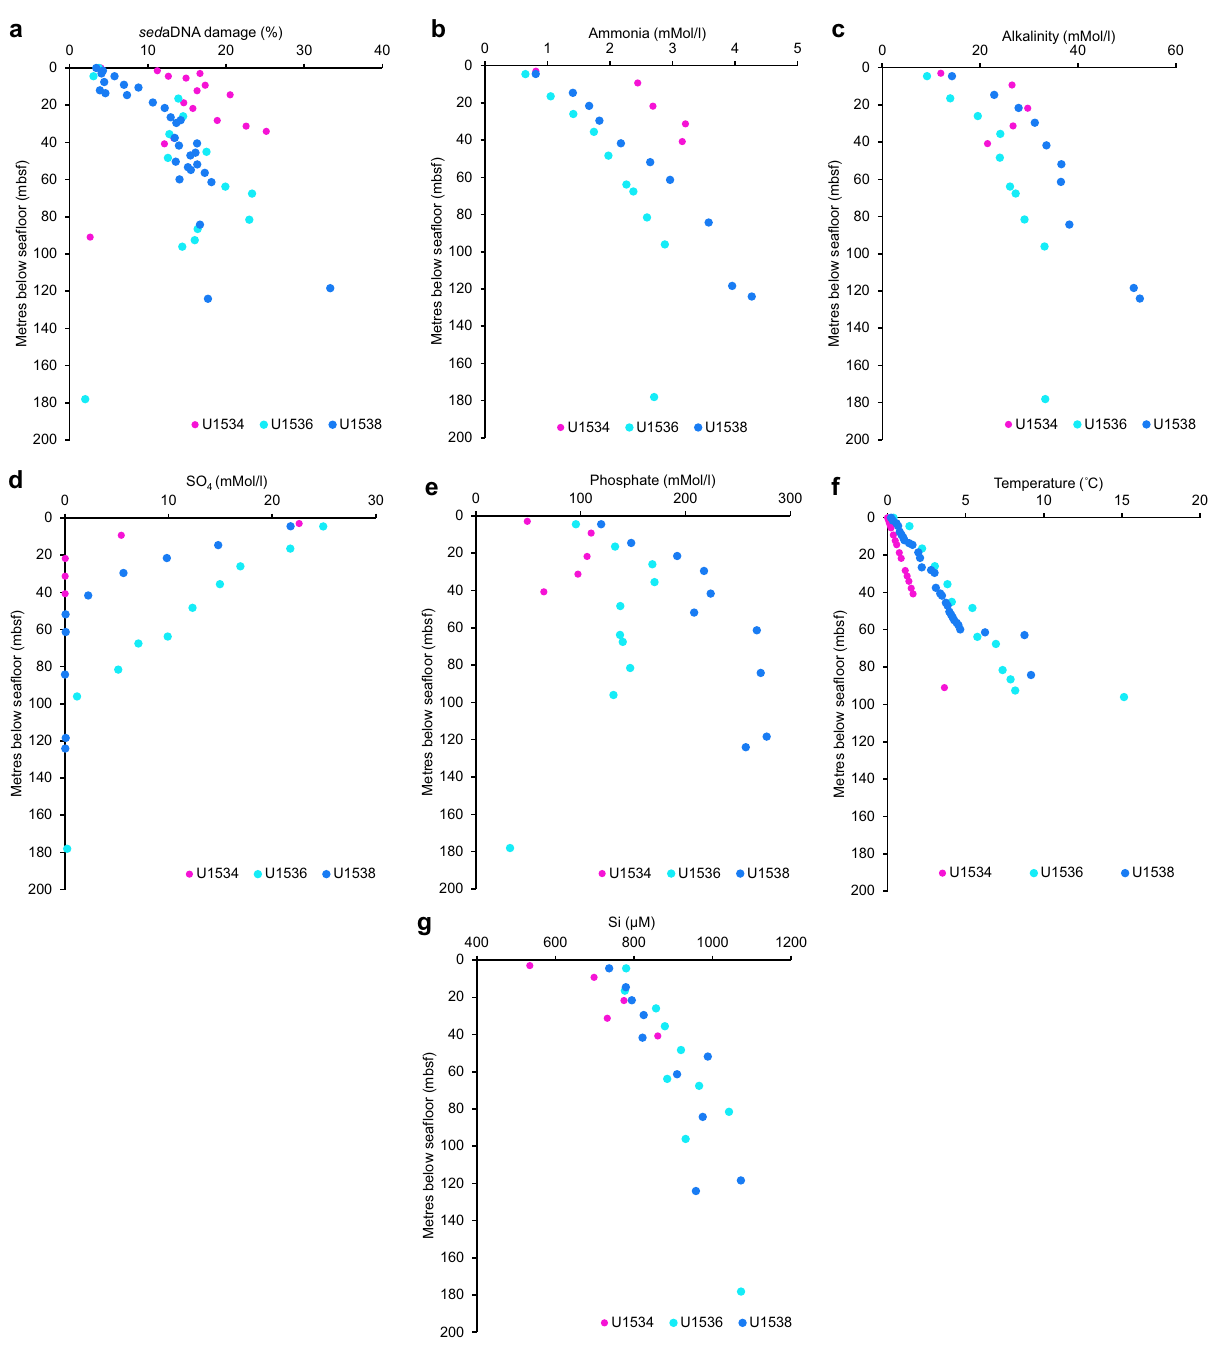
eukaryote sed aDNA damage, including, b ammonia, c alkalinity, d sulfate, e phosphate, f temperature and g silicon. Source data are provided as a Source Data fi